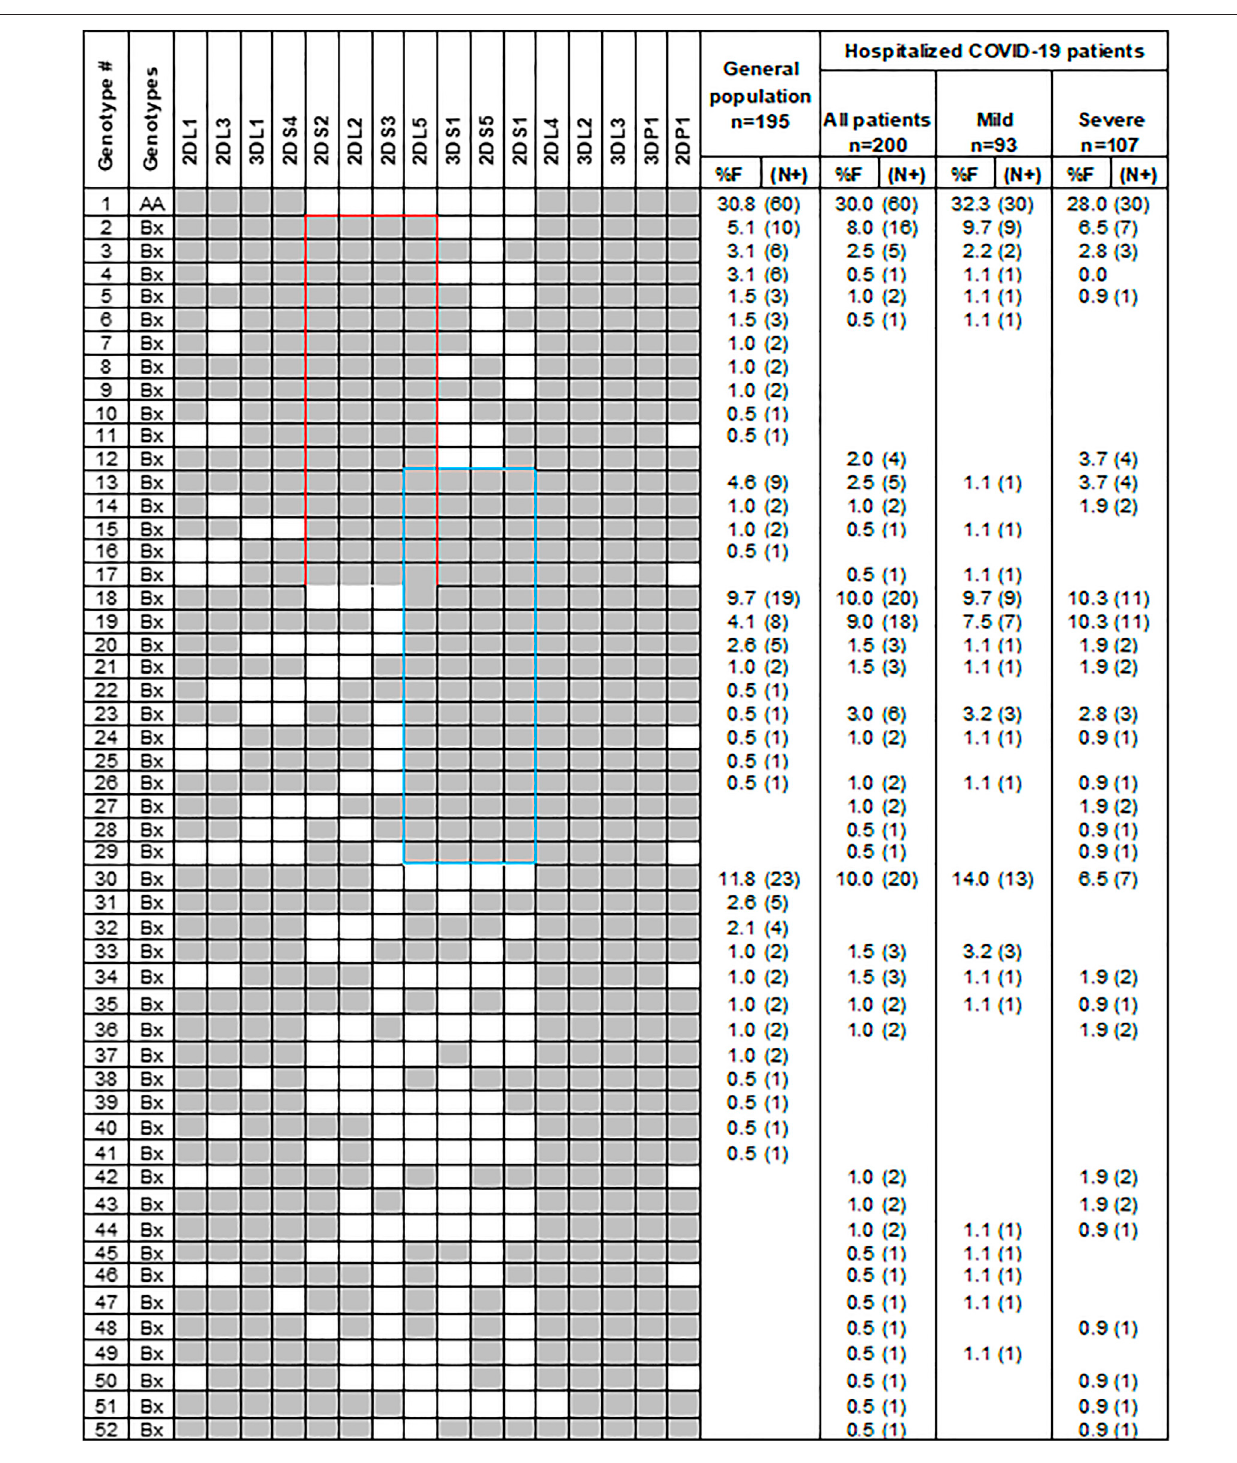
FIGURE2 | Gene contentKIR genotypes in COVID-19 patientsand controls. Fifty-two distinctKIR genotypes differ from each other by thepresence (shaded box) orabsence(whitebox)of16KIRgenes.Thefrequency(%F)ofeachgenotypeisexpressedasapercentageandde fi nedasthenumberofindividualshavingthatspeci fi c genotype (N) divided by the number of individuals studied (n) in each group. Red and blue boxes, respectively, mark the C4 and T4 linkage groups.